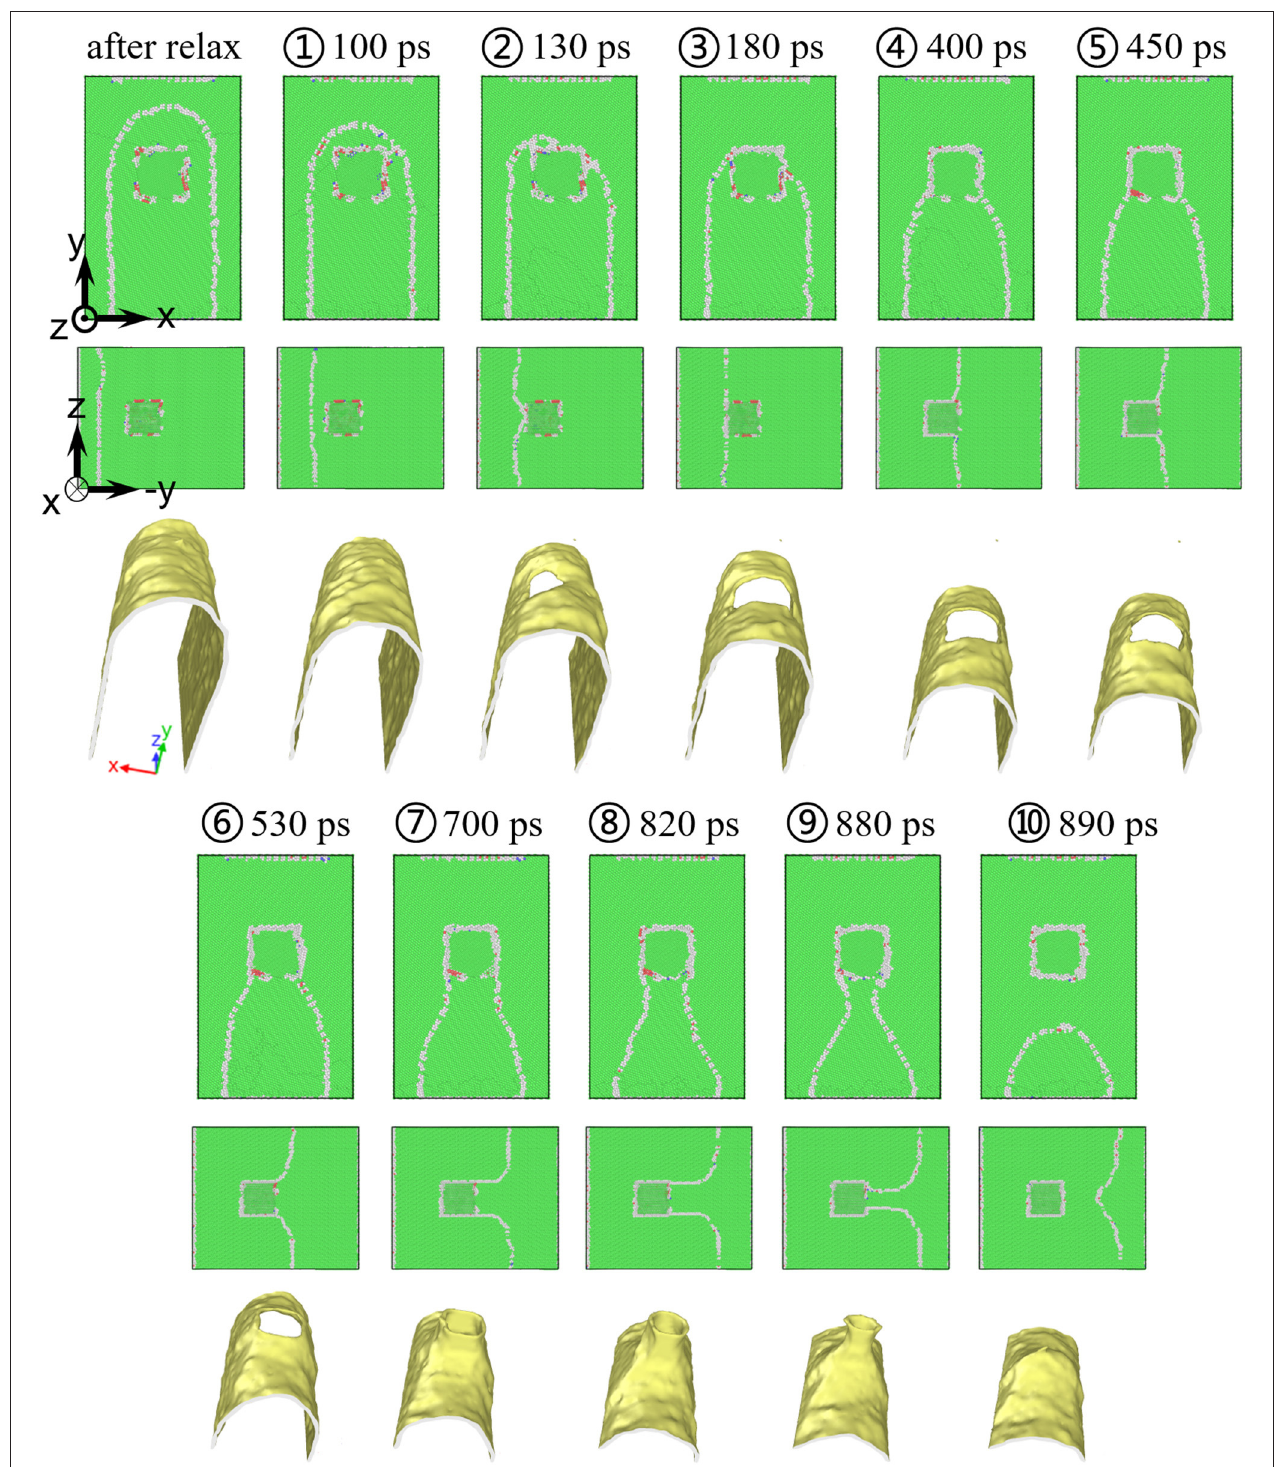
FIGURE 6 | Snapshots and boundary configurations during the GB–particle interaction for the cubic particle with its volume identical to a spherical particle of 6nm diameter. The atoms are colored based on their local environments: green, gray, and red for fcc, disorder, and hcp, respectively (for interpretation of the references to color in this figure legend, the reader is referred to the web version of this